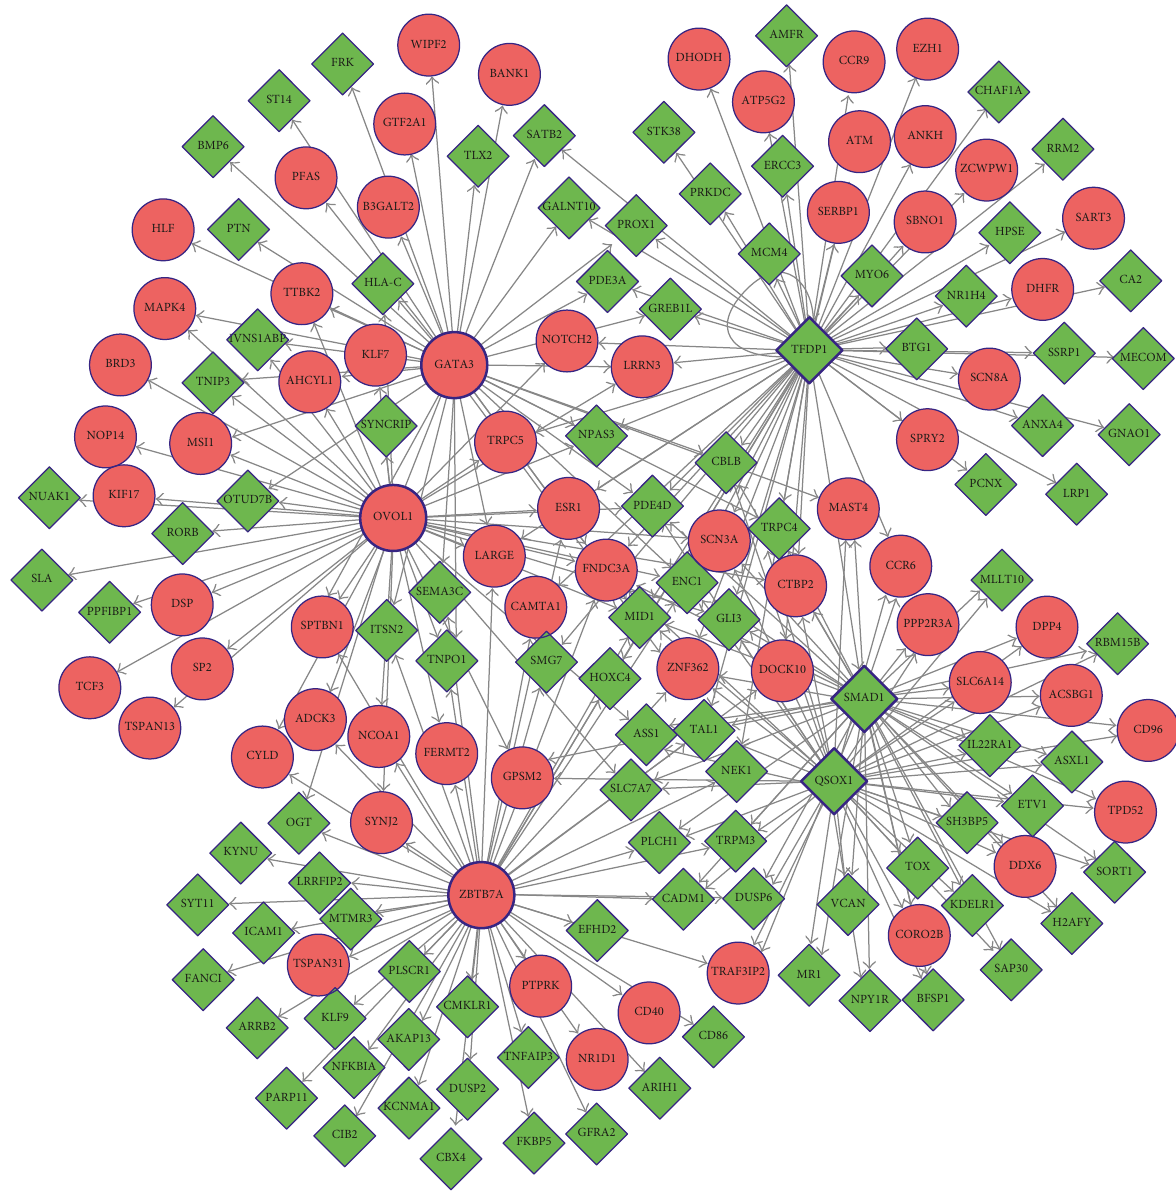
Figure 6: The TF-target regulatory network of differentially expressed genes (DEGs). Blue boxed figures represent TFs, red circles represent upregulated genes, and green diamonds represent downregulated genes. TF, transcription